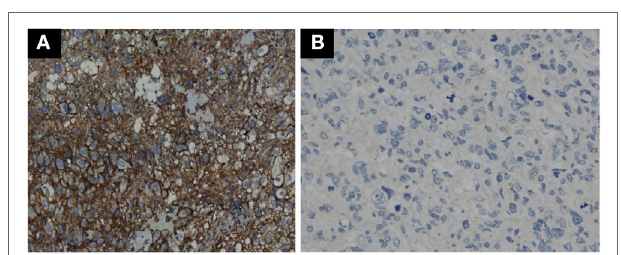
FigUre 3 | Immunohistochemistry staining pattern of positive and negative PD-L1 expression in GBM tumor cells. Representative photomicrographs showing diffuse strong cell membrane staining for PD-L1 (a) , and complete negative staining for PD-L1 (B) in GBM histological tissue sections (400 ×